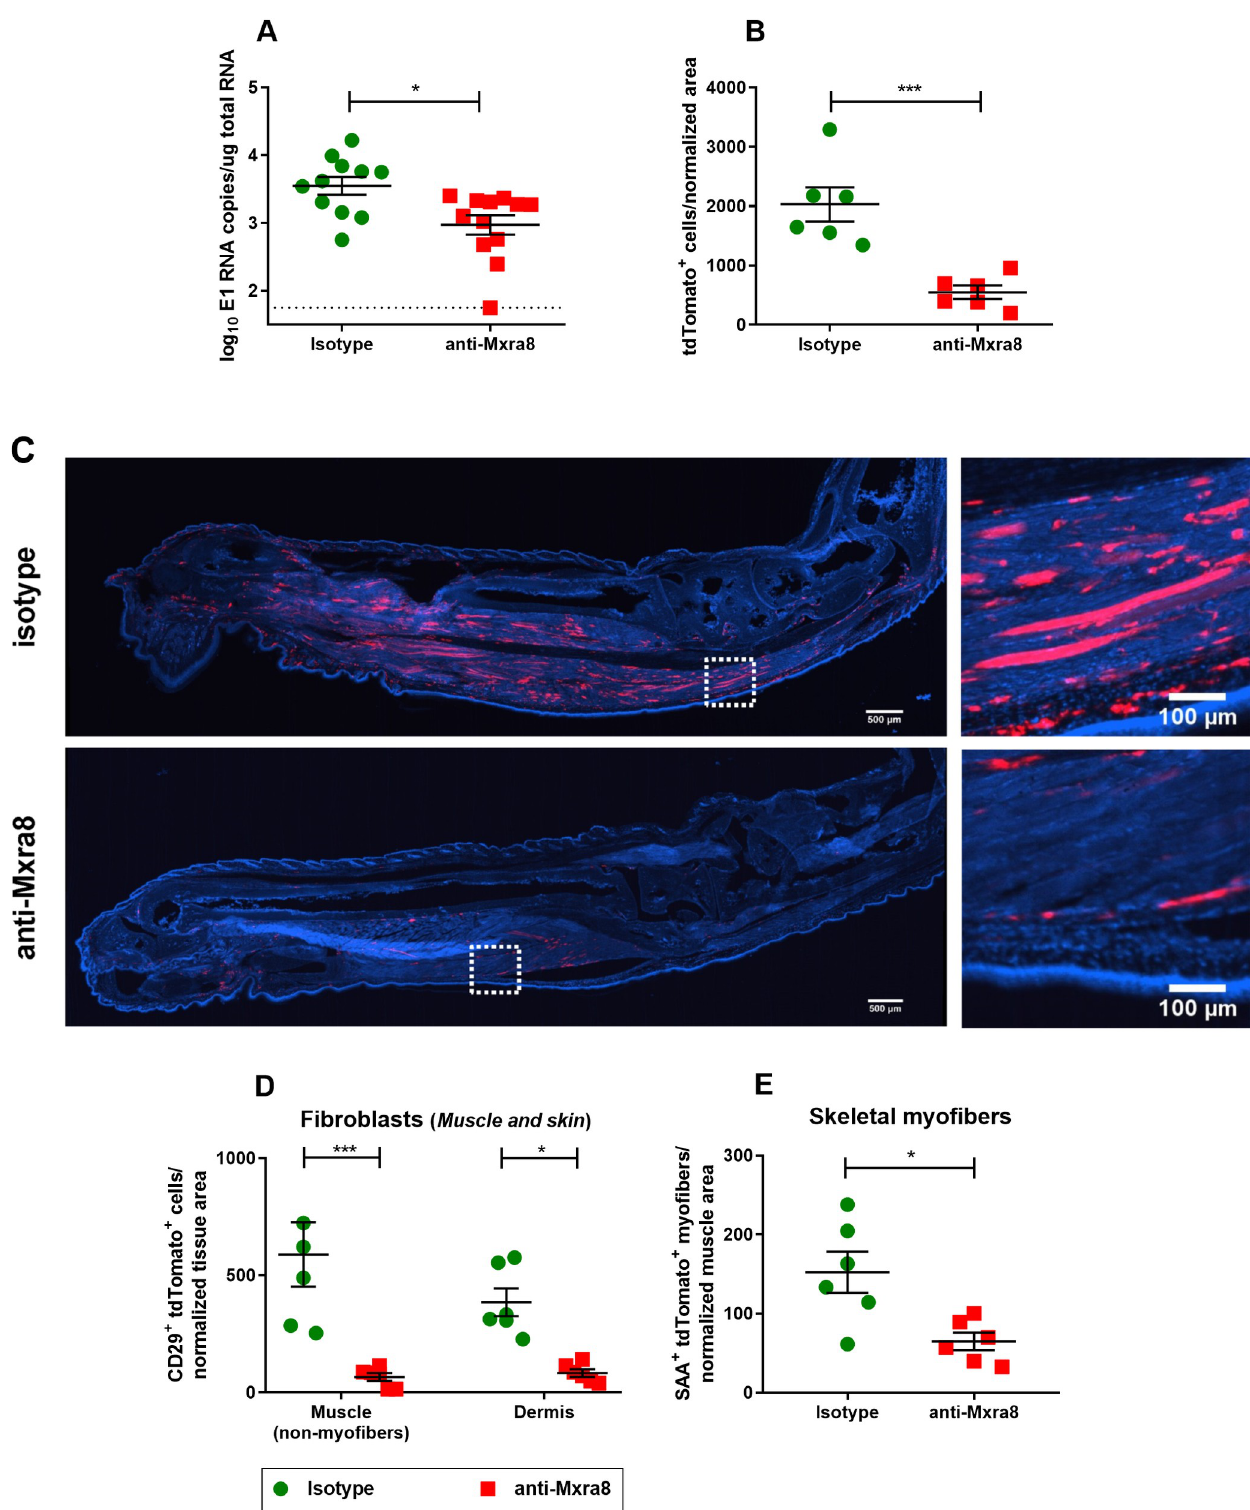
Fig 7. Anti-Mxra8 antibodies reduce levels of viral RNA and the number of tdTomato + cells in the chronic phase of CHIKV infection. tdTomato mice were treated with anti-Mxra8 mAbs (red squares) or an isotype control antibody (green circles) as described in the Methods, inoculated with 10 6 PFU CHIKV-3´-Cre (3´-Cre), and at 28 dpi mice were harvested for quantification of viral RNA and histological analysis. (A) Quantification of CHIKV E1 RNA